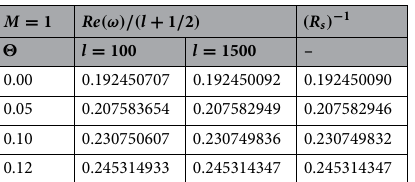
Table 4. The real part of quasinormal frequencies for large l compared with shadow radius R s .